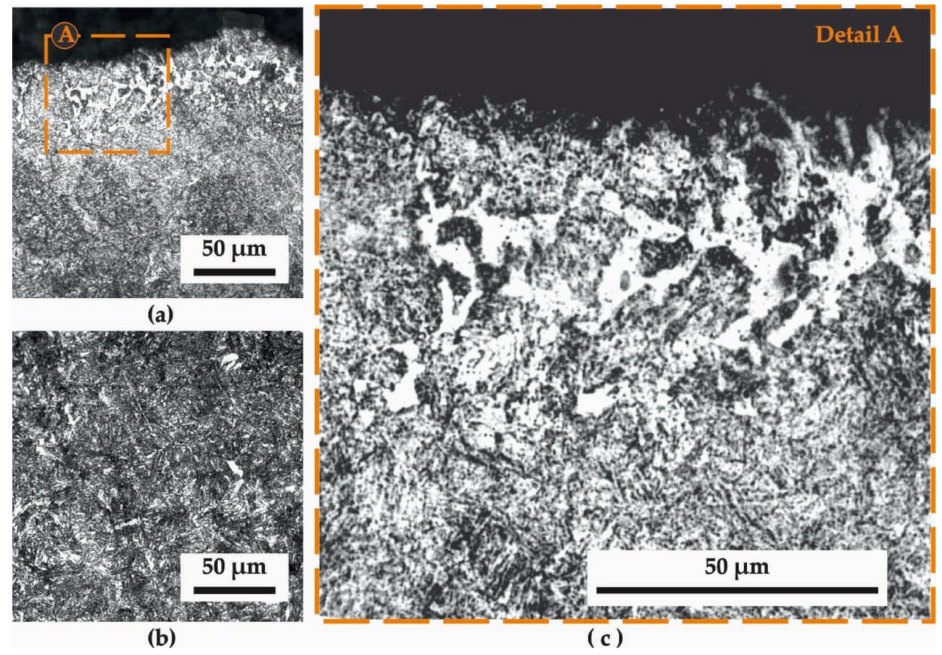
Figure 2. Typical microstructure of the heat treatment and tapering (HTT) specimens (longitudinal section): ( a ) close to the surface; ( b ) at the core ( c ) close to the surface at higher magnification.